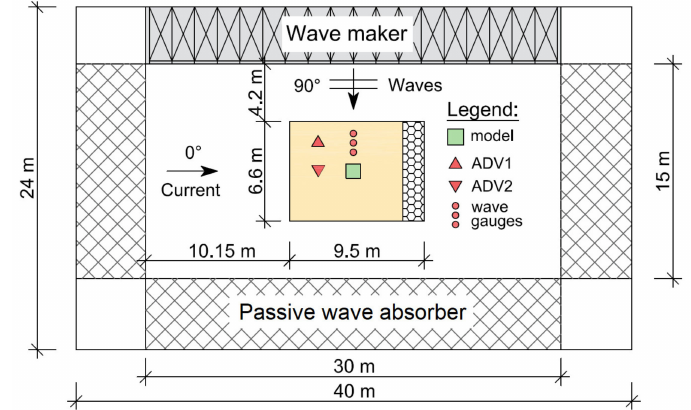
Figure 1. Plan view of the wave current basin with unidirectional current flowing from left to right (0 ◦ ) and perpendicular waves (90 ◦